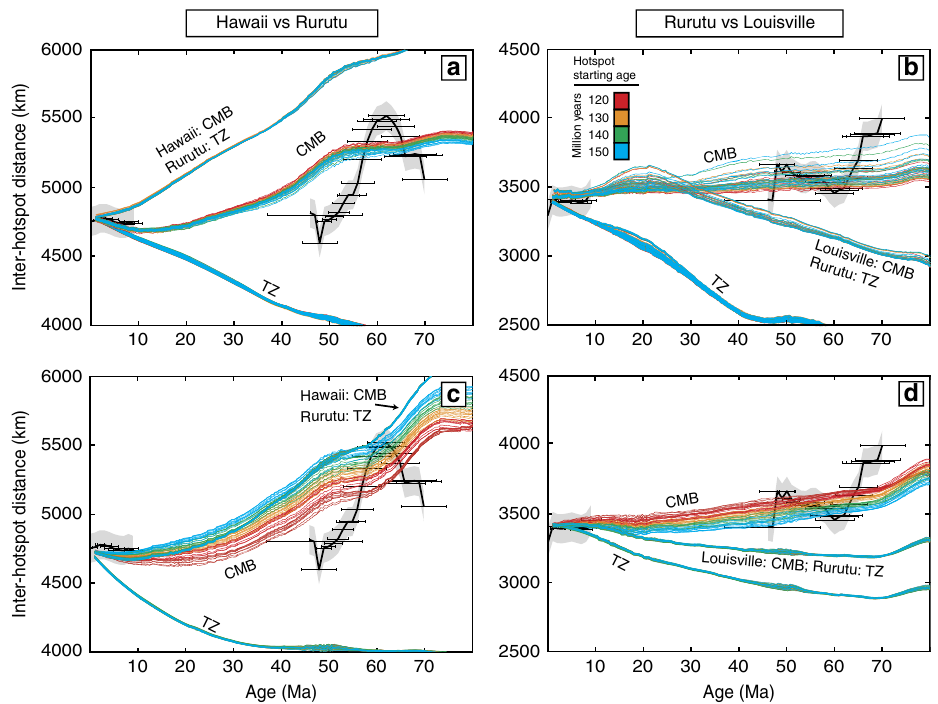
Fig. 3 The inter-hotspot distances compared against modeled plume distances. The distances are from Fig. 2 with additional modeled plume motion comparison of a Rurutu plume generated from the transition zone (TZ) while Hawaii and Louisville are generated from the core-mantle boundary (CMB). All examples shown here assume mobile plume roots. a Hawaii compared against Louisville. b Rurutu compared to Louisville. c Hawaii compared to Rurutu. d Rurutu compared against Louisville. Panels a , b use the viscosity model of Steinberger and Calderwood 56 and tomography model TOPOS362d1 69 with the same age and buoyancy parameters as Fig. 2. Panels c , d use the tomography model SMEAN 62 and the viscosity model of Rudolph et al. 61 . In panel c , Hawaii has an assumed starting age of 150 Ma and buoyancy of 6×10 3 kg/s. In panel d , the modeled Louisville plume assumes a starting age of 120 Ma